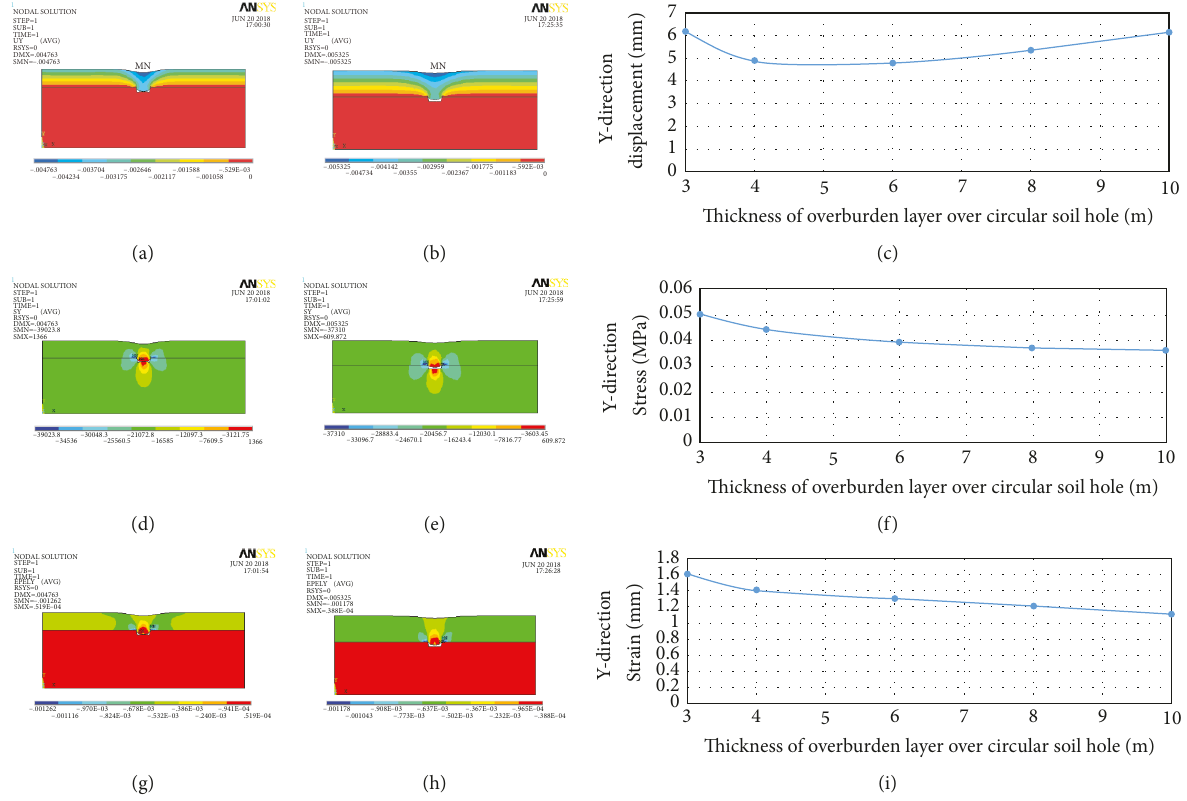
Figure 9: q � 18.43kPa scenario. Results of displacement cloud map: (a) H � 6m and (b) H � 10m; (c) displacement curve; stress cloud map: (d) H � 6m and (e) H � 10m; (f) stress curve; strain cloud map: (g) H � 6m and (h) H � 10m; (i) strain curve.